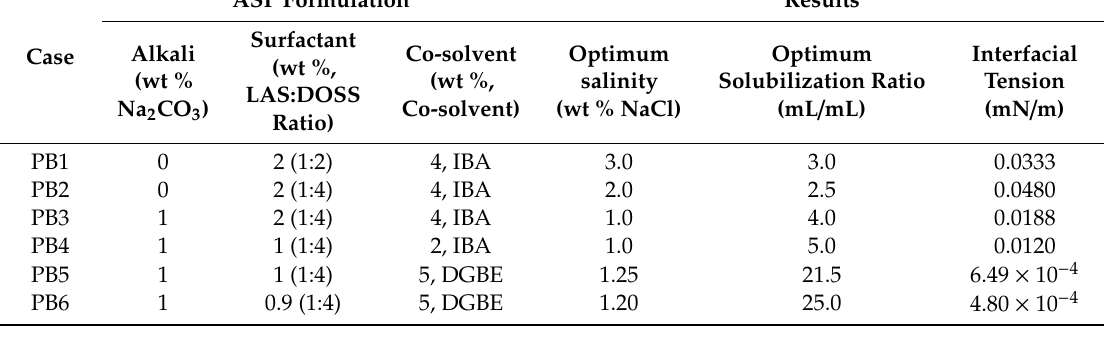
Table 5. Results of phase behavior tests with di ff erent ASP formulations.